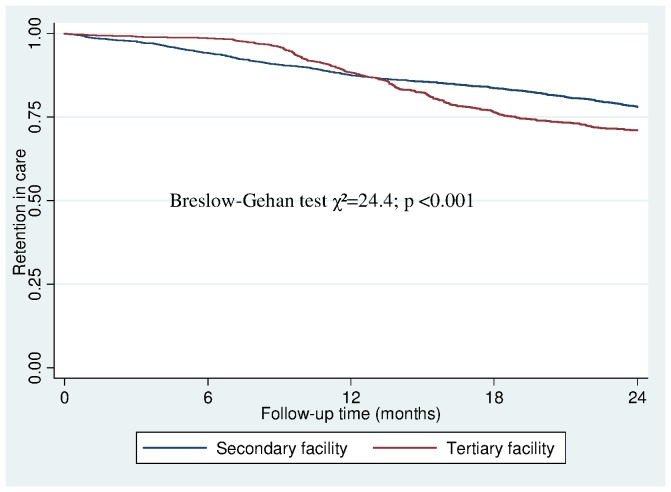
Kaplan-Meier curve showing retention in care for 24 months in secondary and tertiary facilities.(Breslow-Gehan test χ2 = 24.4; p<0.001).